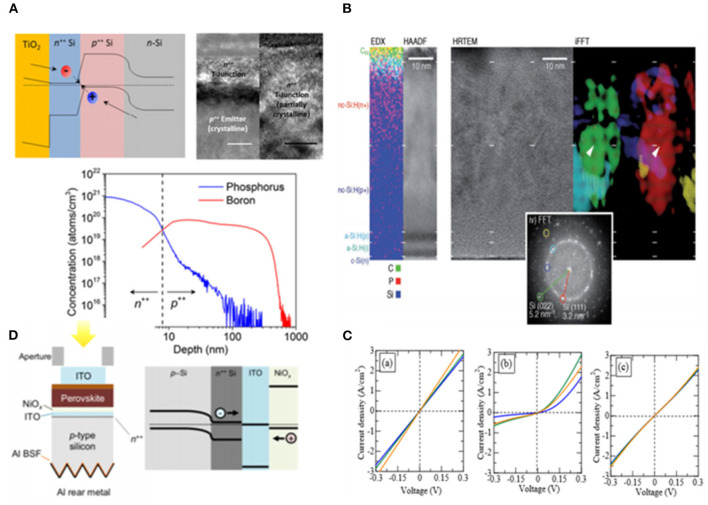
(A) Band diagram, TEM image, and SIMS profile of the PVSK/Si cell tunnel junction interface (reproduced from ref. 67, copyright 2015, AIP). (B) EDX map and corresponding STEM HAADF image of the recombination junction (reproduced from ref. 68, copyright 2017, Wiley ACH). (C) TRJ structure using p-Cu2O:N=n-a-Si:H, and TRJ structure using p-Cu2O:N=n-μc-Si:H (reproduced from ref. 69, copyright 2018, The Japan Society of Applied Physics). (D) Device structure of tandems with Al-BSF p-type Si bottom cells and structure of the ITO/NiOx recombination contact on a p-type Si cell (reproduced from ref. 70, copyright 2018, IEEE).